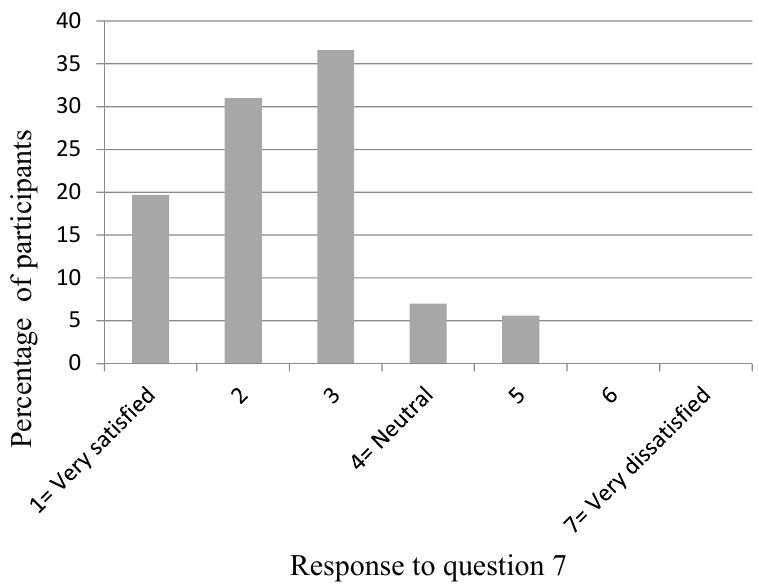
Figure 6. Participants’ response to Question 7: “In general, how satisfied do you think your edentulous patients are with the decision-making process when choosing among different treatment options?” Table 1. Summary of participants’ responses to Questions 3 to 7.